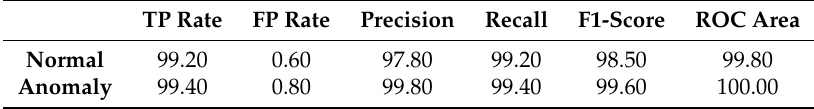
Table 14. Classification report for Ensemble Reptree.